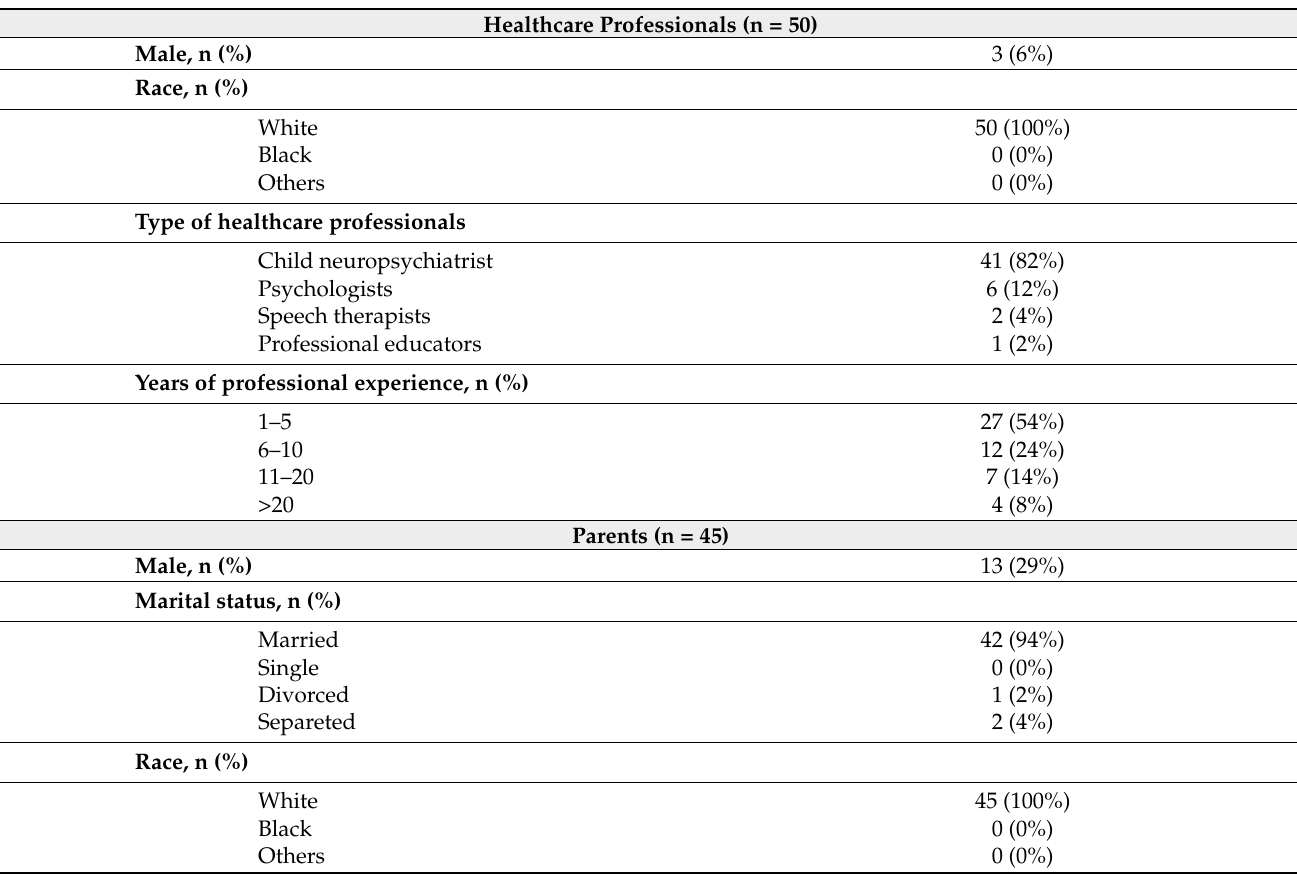
Table 1. Respondents’ characteristics. ASD—autism spectrum